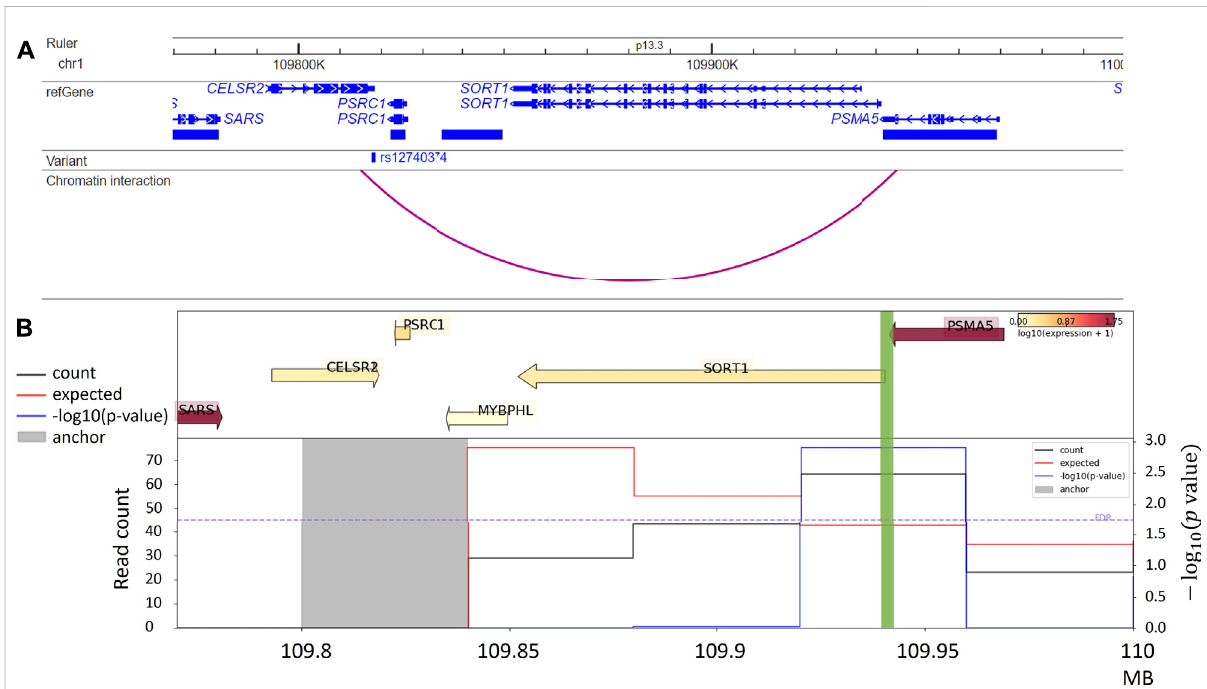
FIGURE 4 (A) Chromatin interaction between rs12740374, an LDL GWAS variant, and promoter of the SORT1 gene, reported by Fulco et al. (2019); (B) Virtual 4C plot from HUGIn (Martin et al., 2017), for the same region in Panel A, shows a signi fi cant chromatin interaction between the anchor bin harborrs12740374(thegrayhighlightedregion)theandthepromoterofthe SORT1 gene(greenhighlight),inhumanlivertissue.Thetoppanelshows gene expression levels and the bottom panel includes three lines quantifying chromatin interactions between the anchor bin and all other bins in the region: black line denotes the observed counts, red line denotes the expected counts, and blue line denotes the -log 10 ( p value).